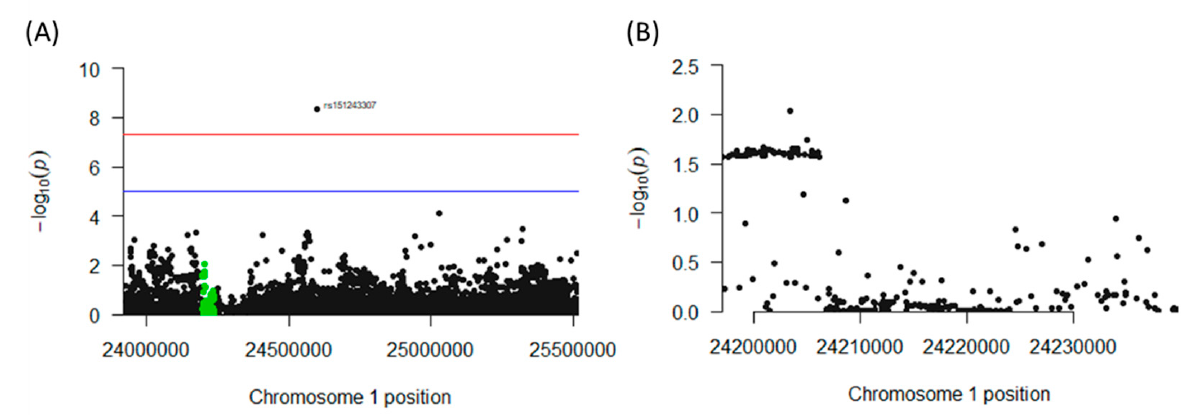
p -values ranging from p = 0.0184 to p = 0.0272 (Figure 8B). The LDs between each pair of tested SNPs as measured by r 2 were uniformly close to 1.0, suggesting close linkage between all 63 SNPs. Interestingly, seven synonymous SNPs in the exon 3 region of CNR2, and a nonsynonymous mutation could be detected. This non-synonymous SNP, rs2501432, exhibited a significant association with p = 0.025. This polymorphism is in strong LD (r 2 = 1) with the other 62 significant CNR2 SNPs. Notably, another SNP (rs151243307) that is located outside of the CNR2 gene but within the haplotype block also appears to be highly significantly associated (4.37 × 10 − 9 ) with the phenotype of the study, and the LD was high with all 63 SNPs (r 2 = 1 for all, Figure S2).